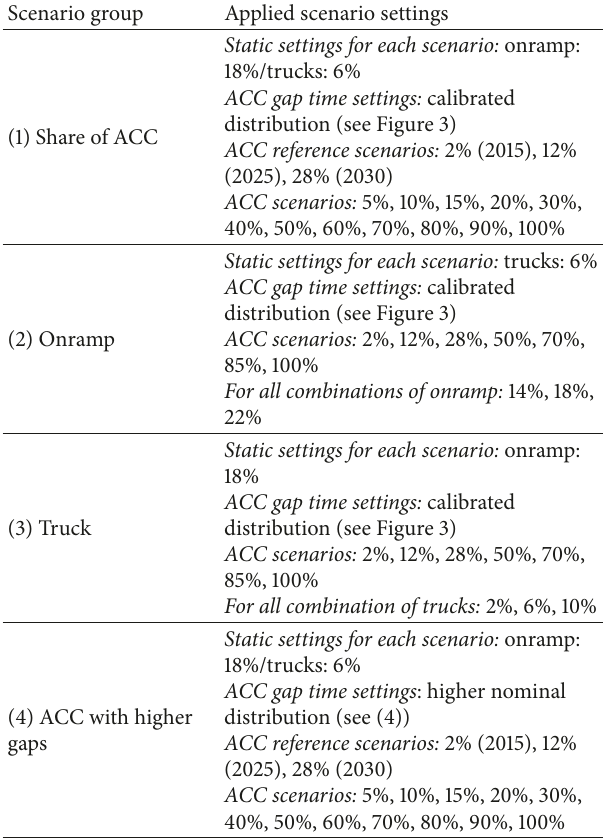
Table 3: Overview of simulated